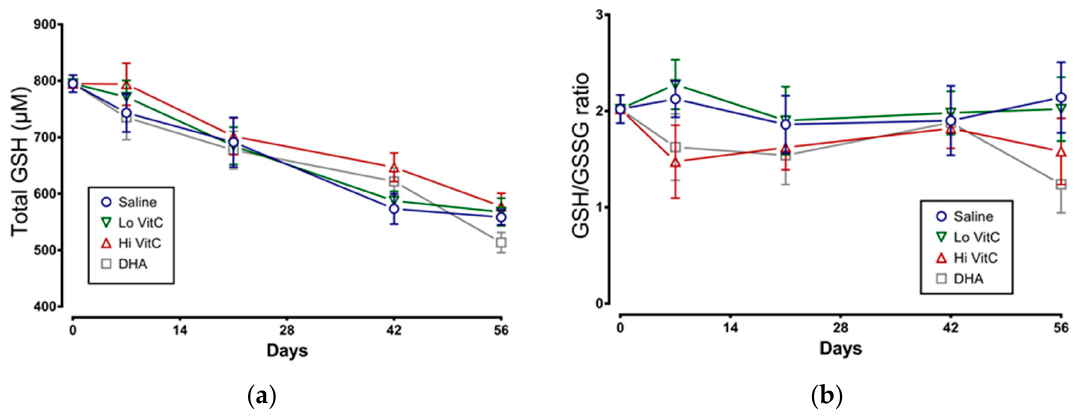
Figure 6. Effect of VitC exposure on glutathione content of stored RBC. ( a ) Total GSH content in RBC stored in saline decreased over 56 days. Addition of reduced VitC (Lo/Hi) or oxidized VitC (DHA) did not significantly alter the total GSH content from stored RBC. ( b ) There was a slight decrease in the GSH/GSSG ratios on Day 7 with Hi-VitC and DHA-treated RBC. However, this decrease was not statistically significant. ( N = 5/group, p > 0.05).